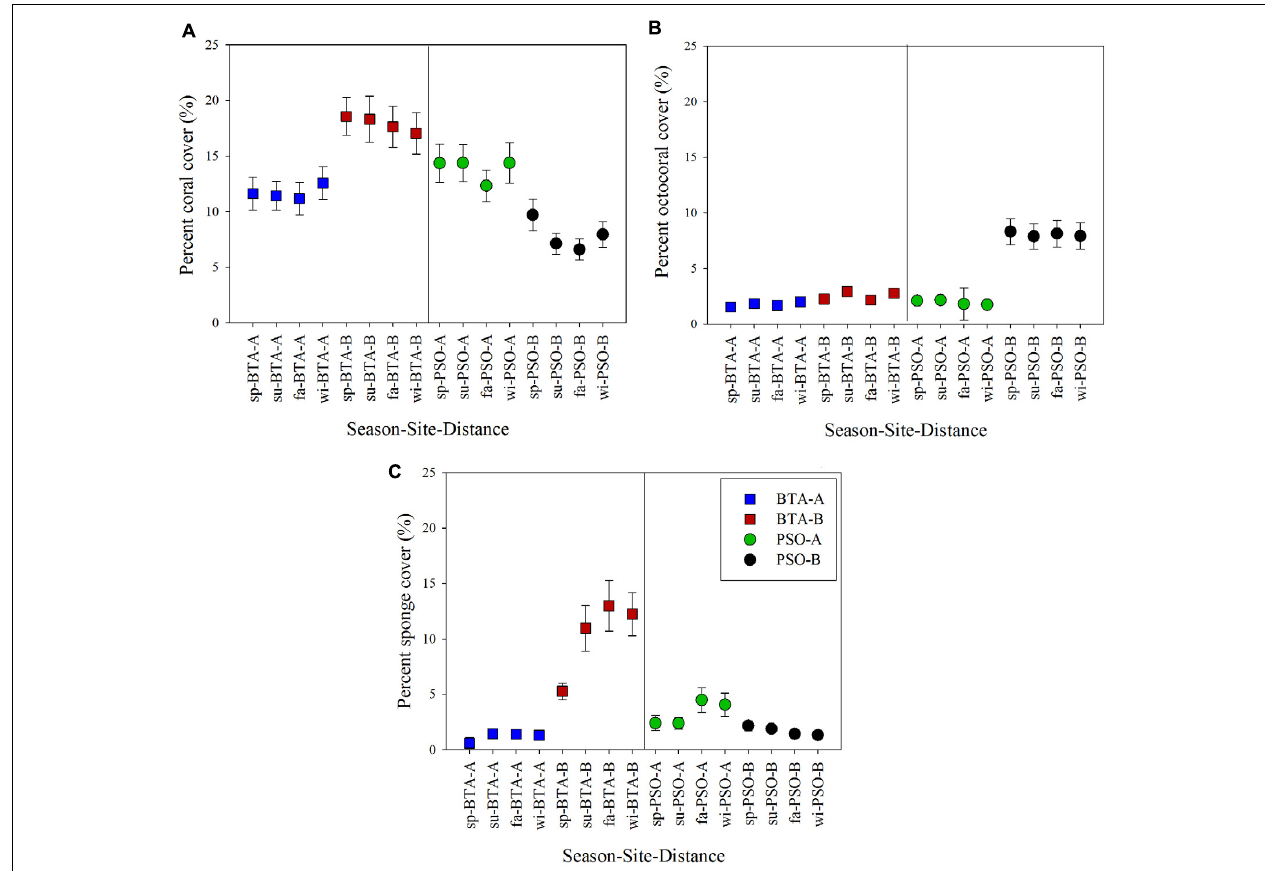
FIGURE 7 | Coral reef benthic components cover across a distance gradient from shore and seasons (mean ± 95% CI). Percent coral cover (Scleractininas + hydrocorals) (A) , octocoral cover (B) , and sponge cover (C) . Blue and red squares represent Bahía Tamarindo (BTA); green and black represent Punta Soldado (PSO). Seasons are defined as: sp, spring; su, summer; fa, fall; wi,